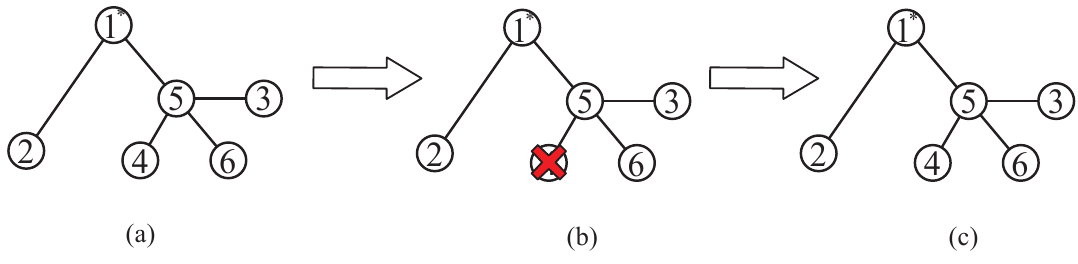
Figure 6. The topologies of pump intelligent nodes. ( a ) Toplogy with all 6 pumps working in normal; ( b ) Topolgy with Pump 4 out of service; ( c ) Topolgy with Pump 4 back to